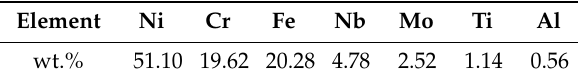
Table 2. Chemical composition of raw Inconel 718.